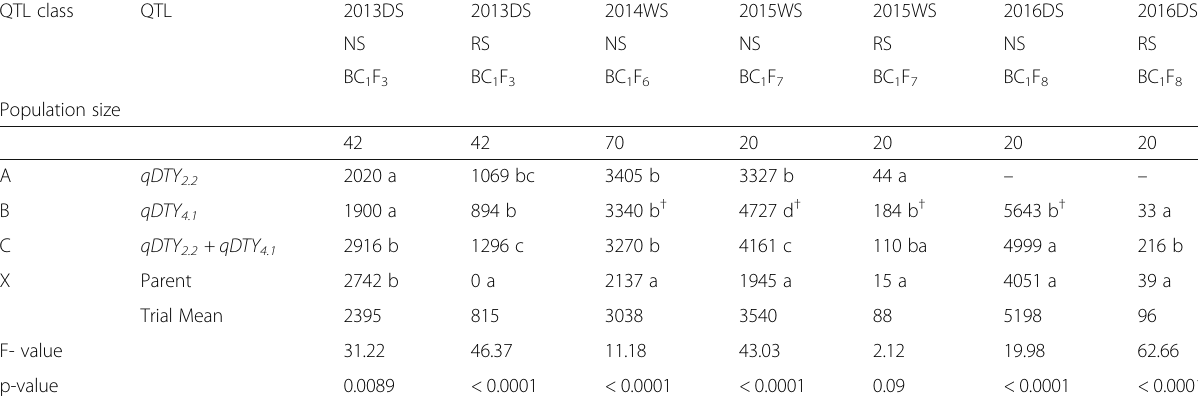
Table 3 Mean comparison of QTL classes of grain yield (kg ha − 1 ) across BC 1 F 3 to BC 1 F 8 generations under reproductive-stage drought stress and irrigated non-stress control conditions in Samba Mahsuri background at IRRI,